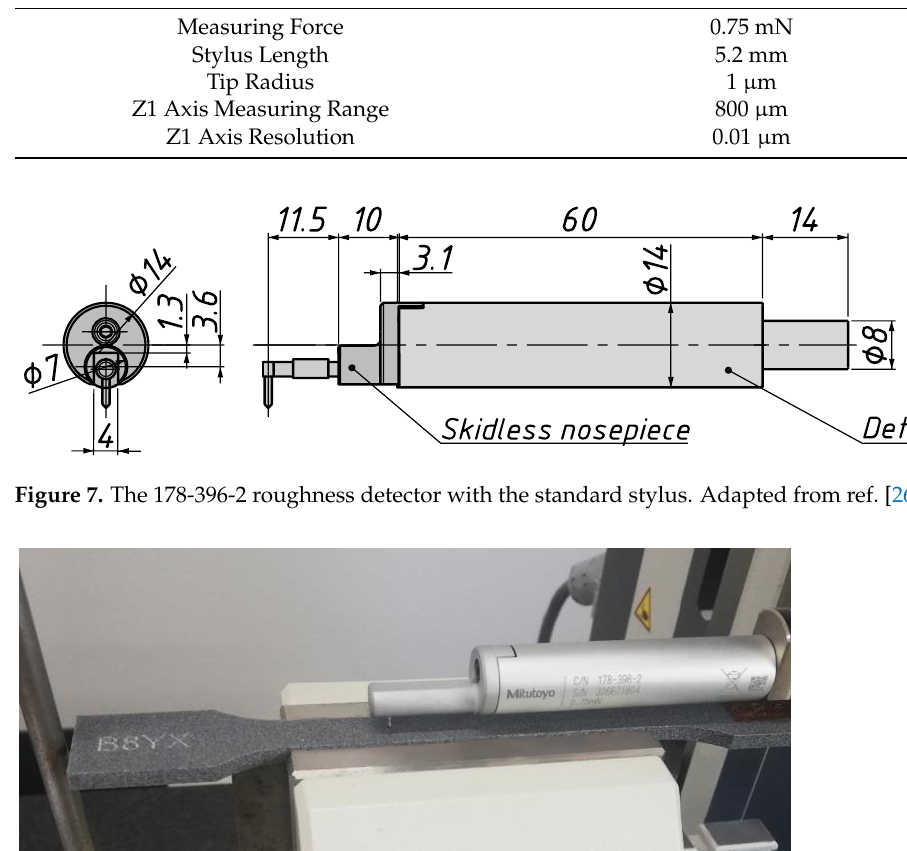
Table 3. Roughness measurement